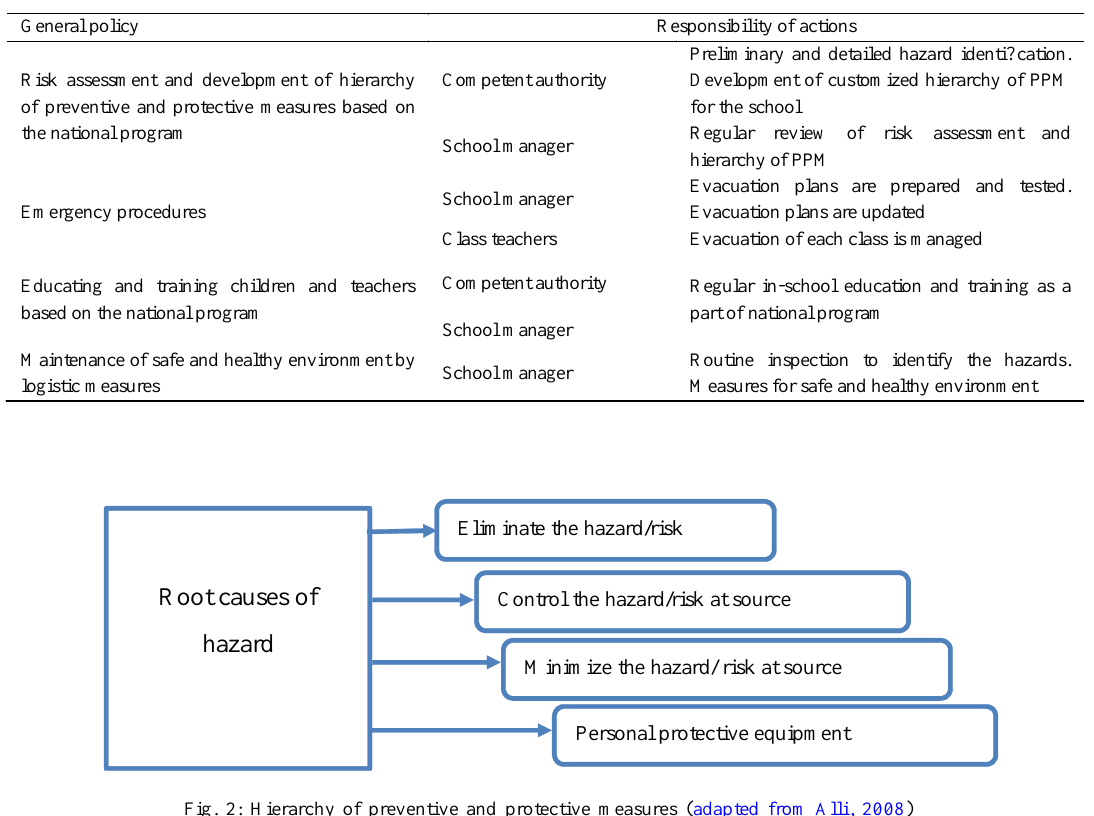
Fig. 2: Hierarchy of preventive and protective measures (adapted from Alli, 2008)